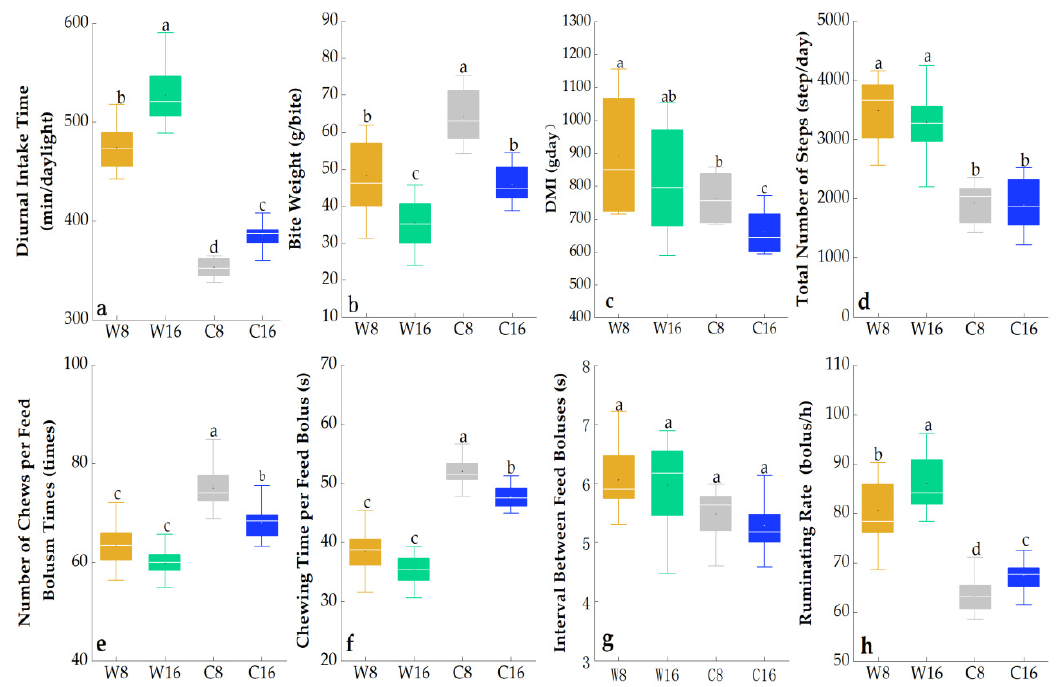
Figure 7. Effects of grazing season (warm and cold) and stocking rate (8 sheep/ha and 16 sheep/ha) on mean (± SE) gazing behavior in the two years (2010 and 2011). Means within a column with different letters significantly differ ( p < 0.05).